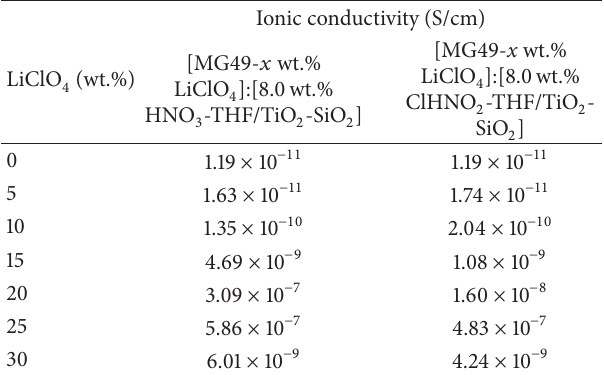
Table 1: LiClO 4 salt concentration-dependence ionic conductivities (S/cm) at room temperature.